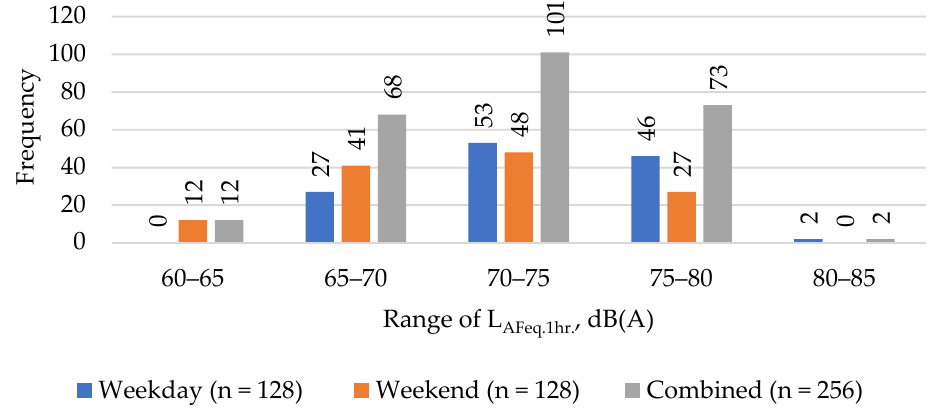
Figure 2. Hourly noise level (L AFeq . 1h .) histogram.